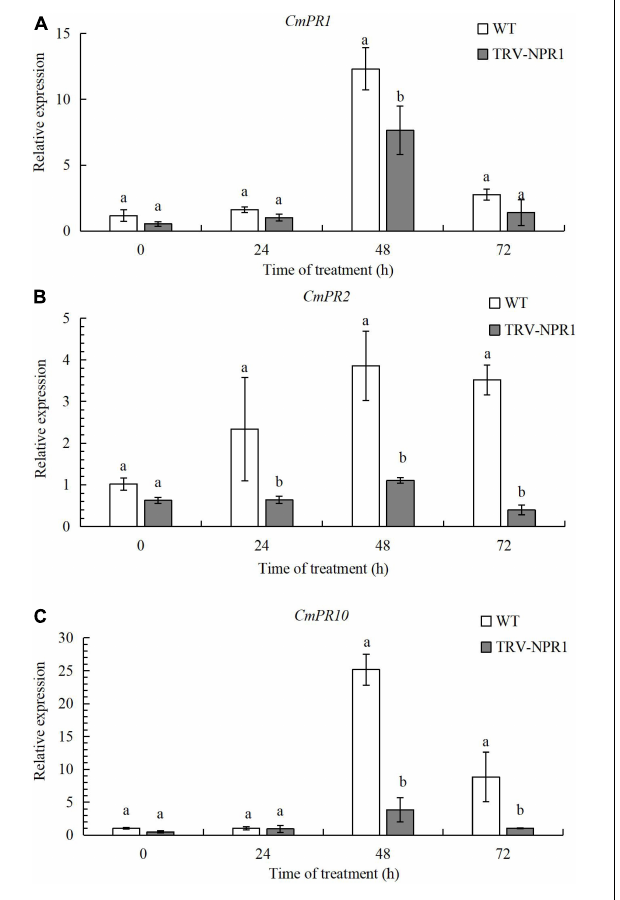
FIGURE 5 | Transcript levels of CmPR1 (A) , CmPR2 (B) , and CmPR10 (C) genes determined by RT-qPCR. Error bars show SD of three replicates. Different letters demonstrate significantly different by Duncan’s multiple range test at p <